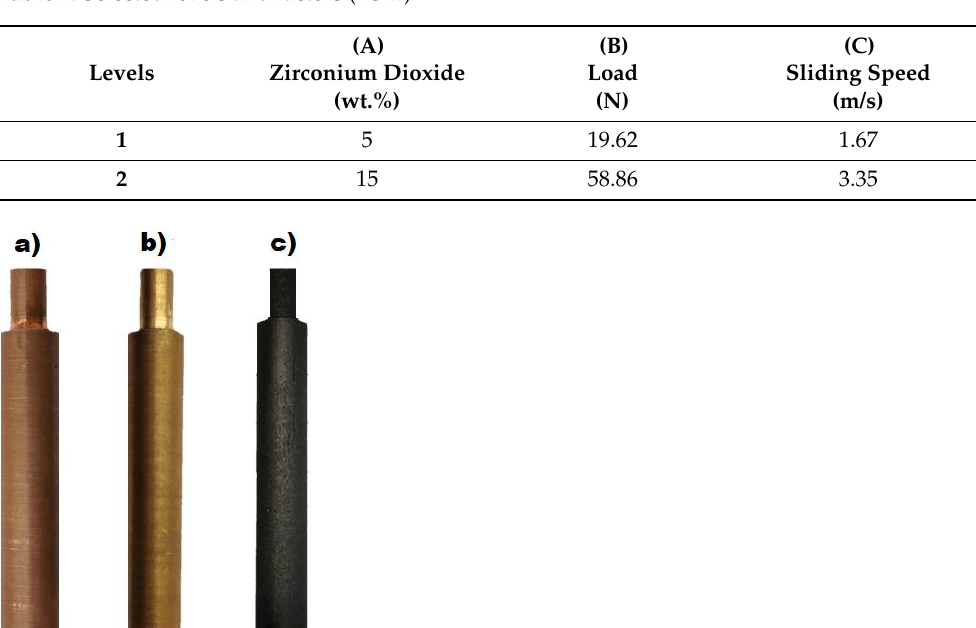
Figure 8. Electric dischargemachining set up. In the present study of electric discharge machining operation, five parameters, electrode material, peak current (A), pulse on time (µs), pulse off time (µs), and ZrO 2